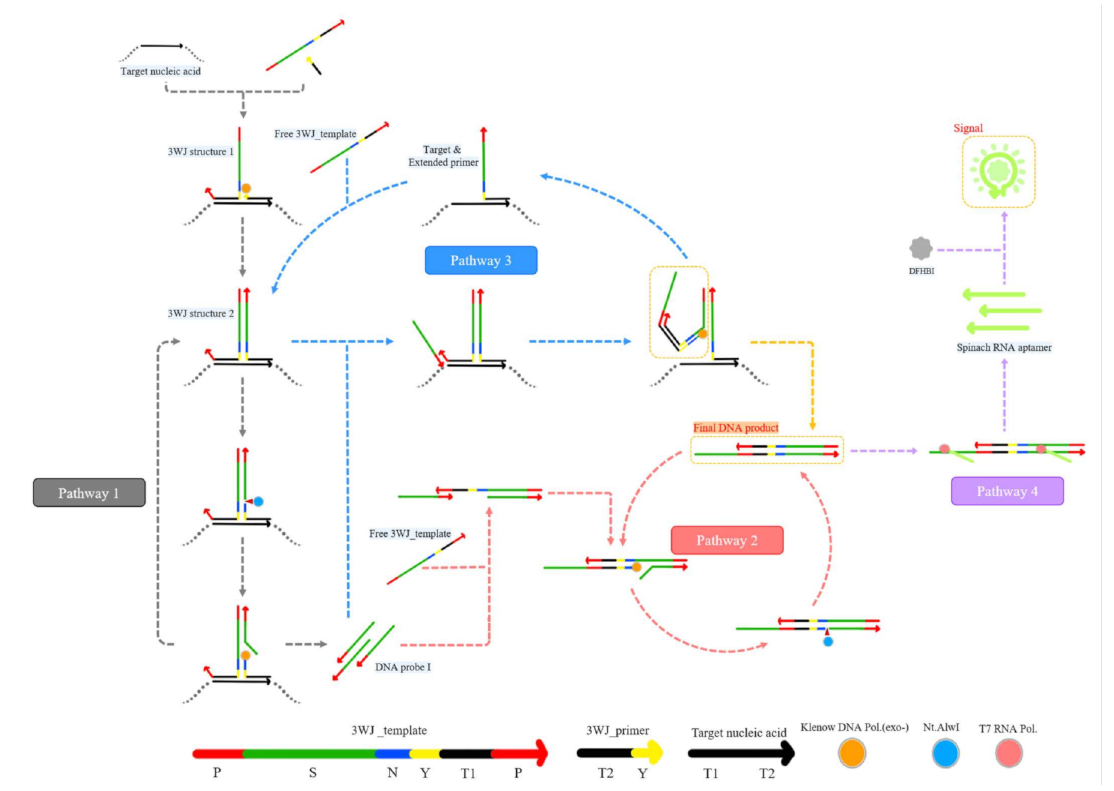
Figure 1. Schematic illustration of a 3WJ-induced transcription amplification for the detection of target nucleic acids. P, promoter sequence (red); S, light-up RNA aptamer sequence (green); N, recognition site for Nt.AlwI (blue); Y, sequence that mediates the formation of 3WJ (yellow); T1, target-specific region (black); T2, target-specific region